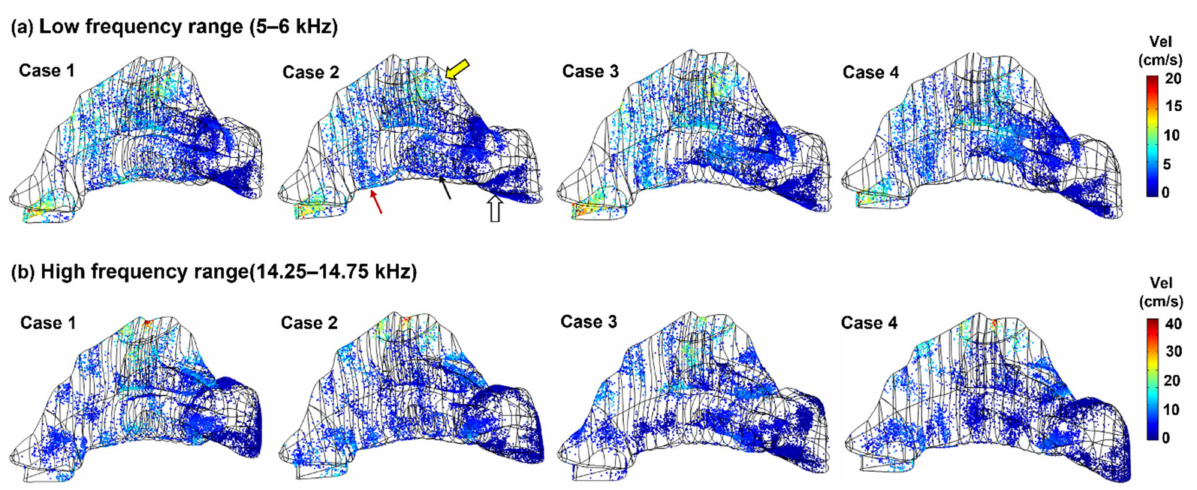
Figure 9. Comparison of particle surface deposition distribution among four nasal geometries: ( a ) low-frequency range (5–6 kHz), and ( b ) high-frequency range (14.25–14.75 kHz).